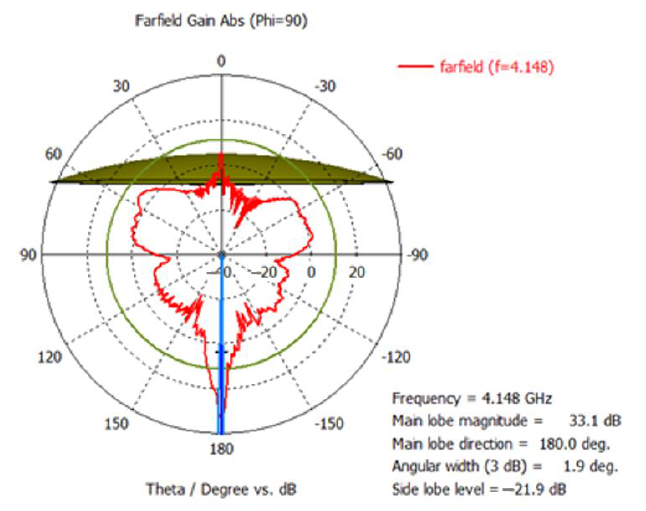
Figure 9. E-plane radiation pattern of array antenna combined with a 2.4-m parabolic reflector.